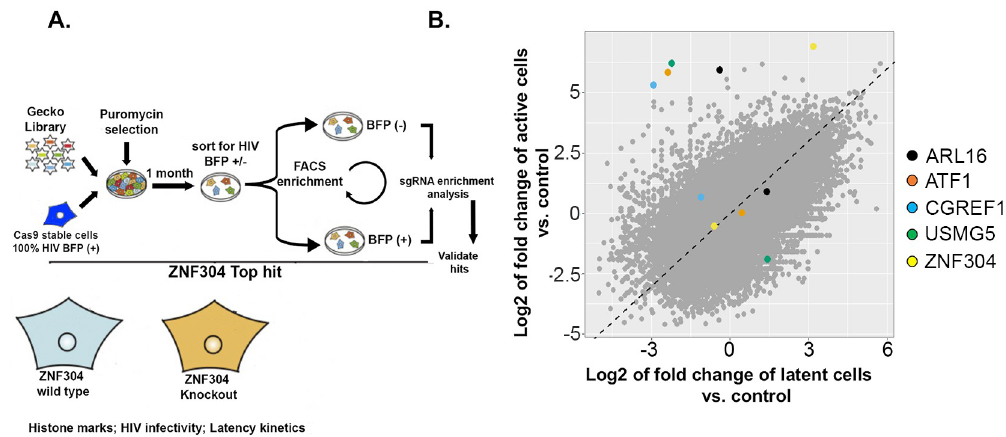
Fig 1. Genome-wide CRISPR knockout screen for identifying host factors that promote HIV latency. A . Schematic representation of the genome CRISPR KO screen towards identifying host factors that modulate HIV gene transcription and viral latency by using the GeCKO library. B . Scatter plot showing enrichment of sgRNA in activated or latent cells relative to control unsorted latent cells. Plot was generated by the CRISPR analyzer. Differences in enrichment were calculated as log2-normalized fold of change. The indicated colored sgRNAs were significantly enriched in our screen; of these the highest- ranking gene was ZNF304. This gene was detected across two independent screens and was thus chosen for further validation and mechanistic investigation. Dots near the diagonal represent sgRNA with no enrichment between latent or activate state of HIV.